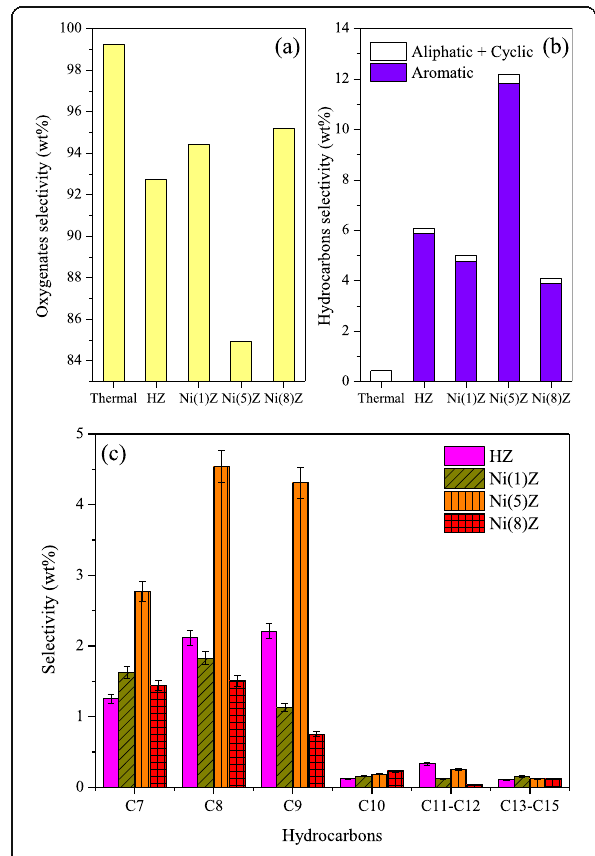
Fig. 3 Selectivity towards ( A ) oxygenated compounds, ( B ) hydrocarbons and ( C ) C-atoms per molecule of hydrocarbon in biooils from PS pyrolysis catalyzed by